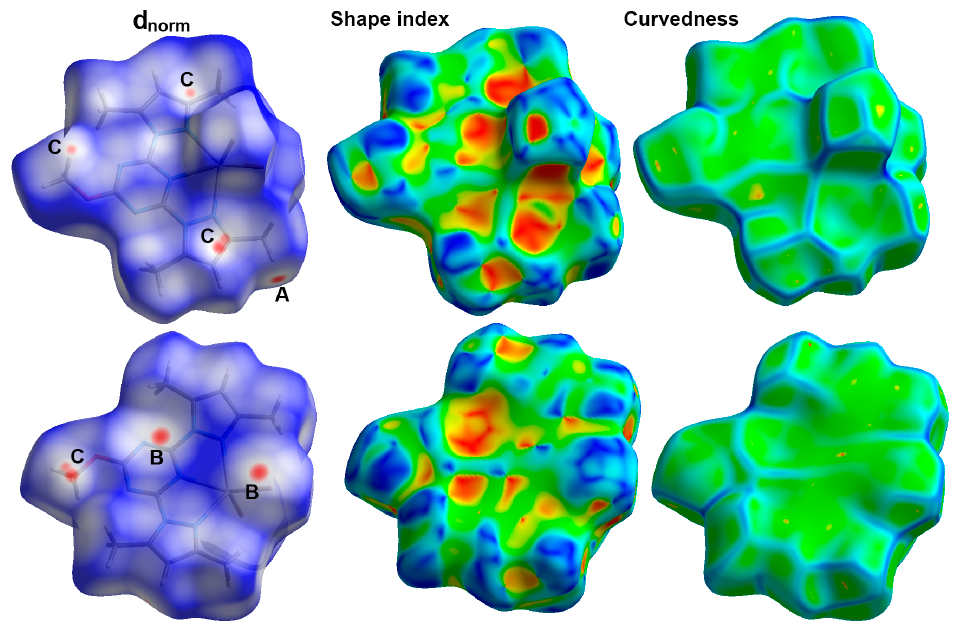
Figure 5. Hirshfeld surfaces of the [Cd(BPMT)Br 2 ] complex. The shape index and curvedness maps revealed the absence of aromatic π - π stacking interactions.